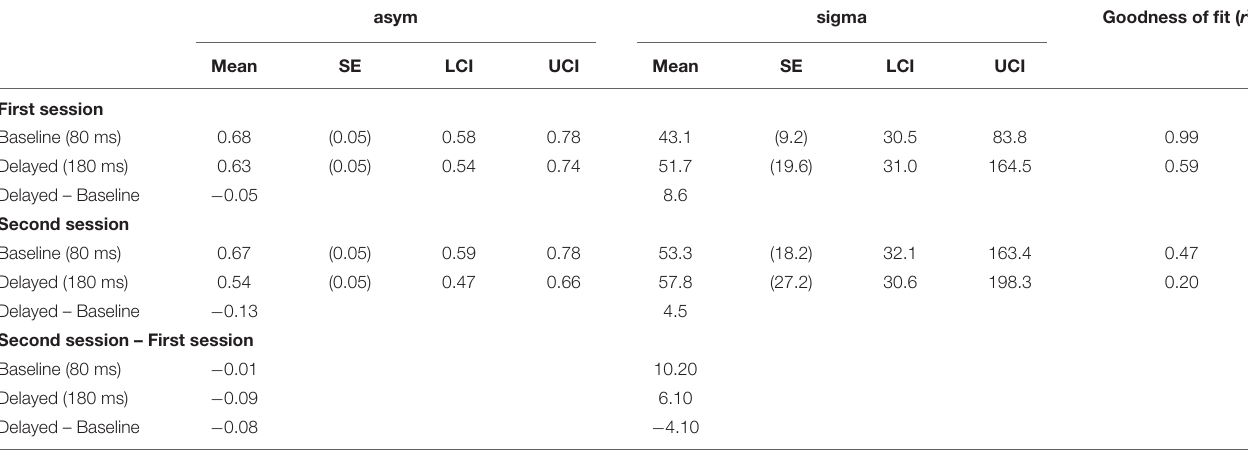
asym sigma Goodness of fit ( r 2 )